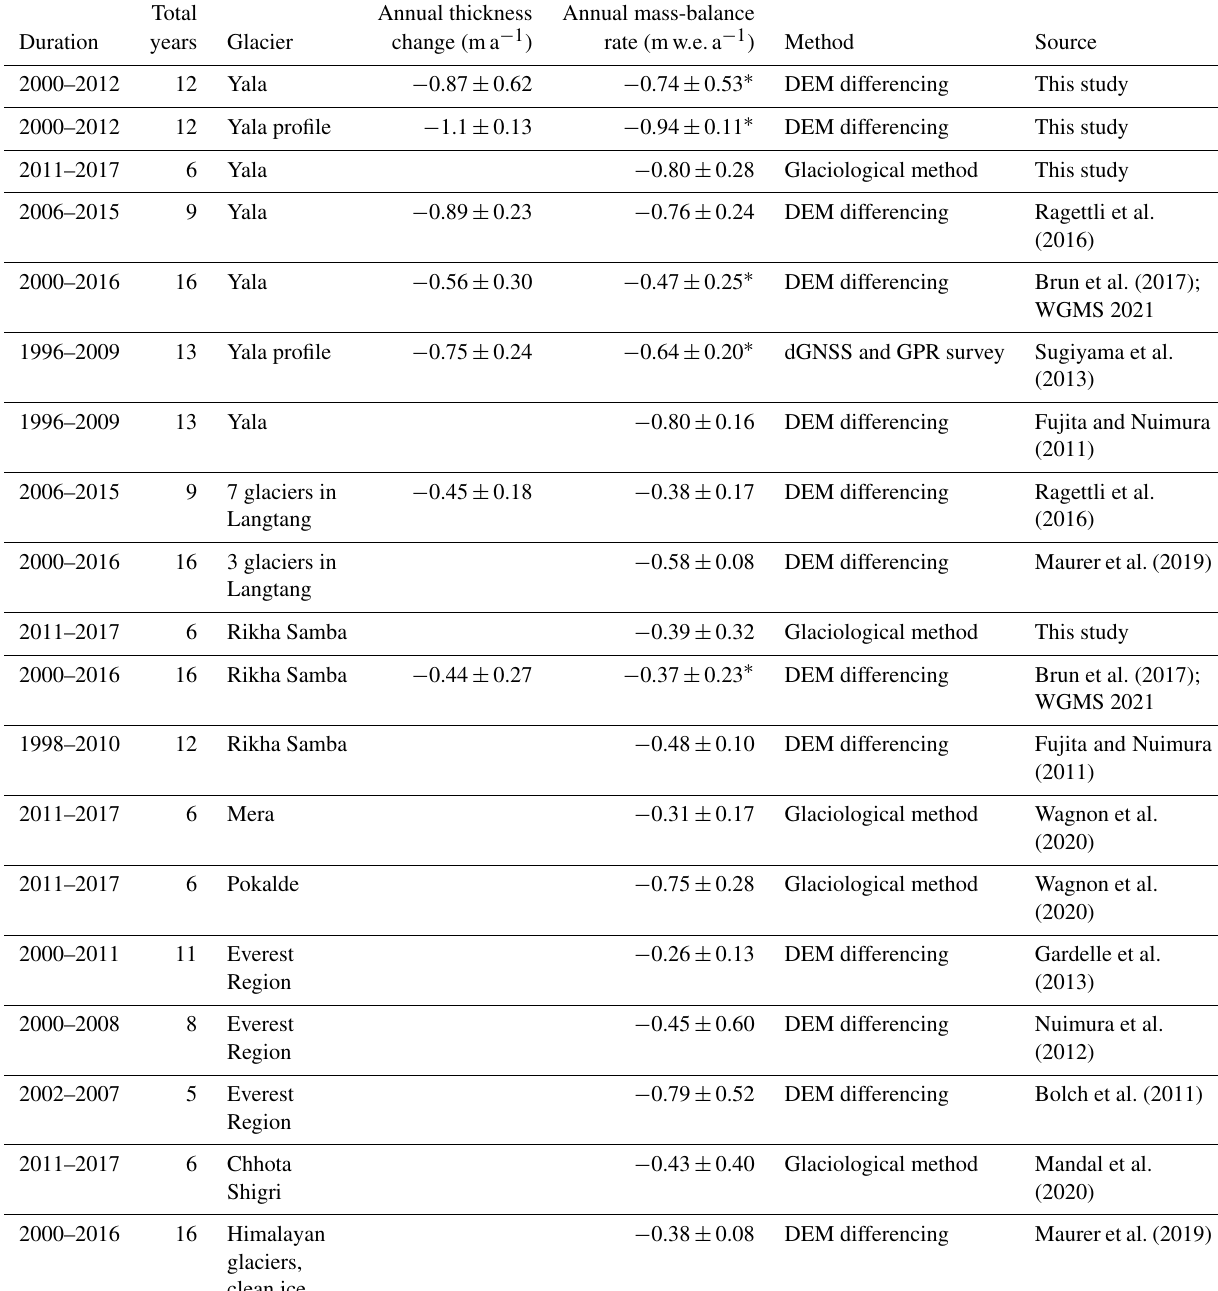
Table 6. Comparison of glacier surface lowering and in situ mass-balance measurements from various studies. Conversions of thickness change ( ∗ ) calculated assuming a density of 850kgm − 3 and annual uncertainties calculated based on authors’ values and Zemp et al.